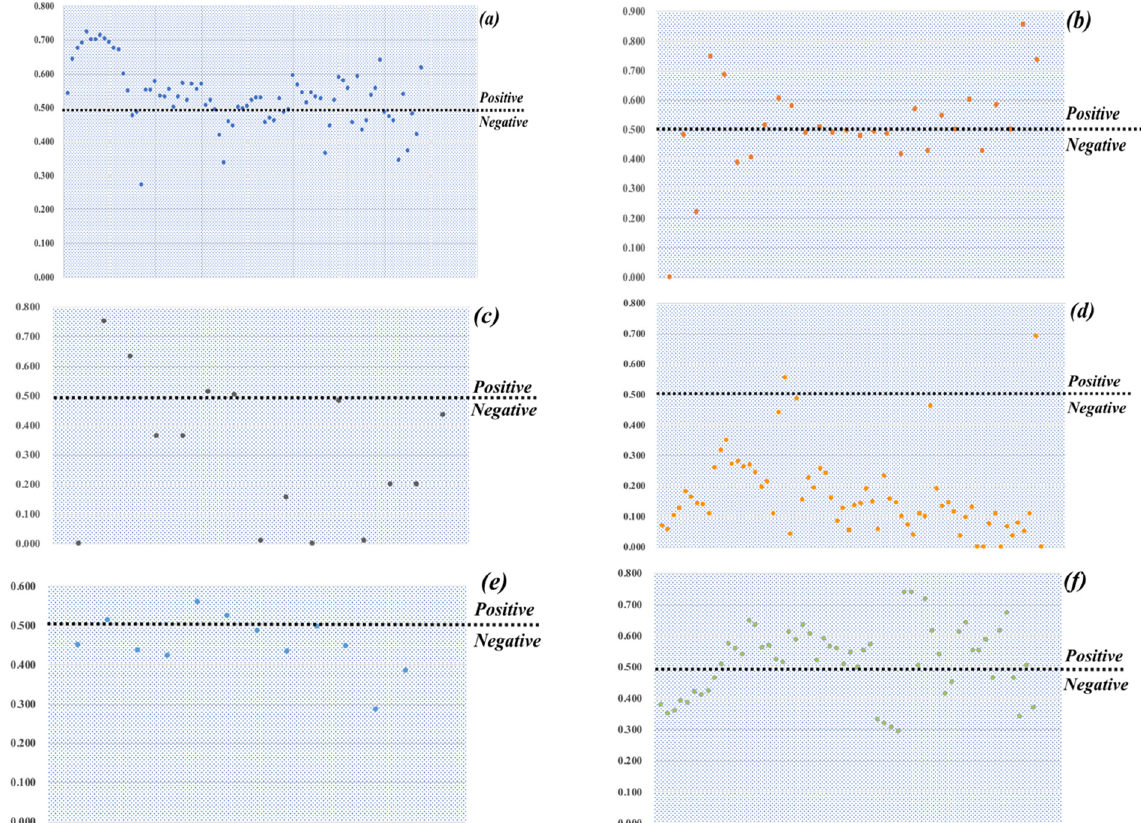
Figure 12. Sentiment analysis for the six themes (( a ) # Wuxi Viaduct collapse in Jiangsu province #, ( b ) #Wuxi police reported viaduct collapse#, ( c ) # The viaduct was designed by JSTI Co., Ltd.#, ( d ) # 3 dead, 2 injured in Wuxi Viaduct collapse #, ( e ) # The boss of Wuxi Success Transportation Co., Ltd., the vehicle’s owner, was taken away by police #, ( f )# One of the victims was a single father #).